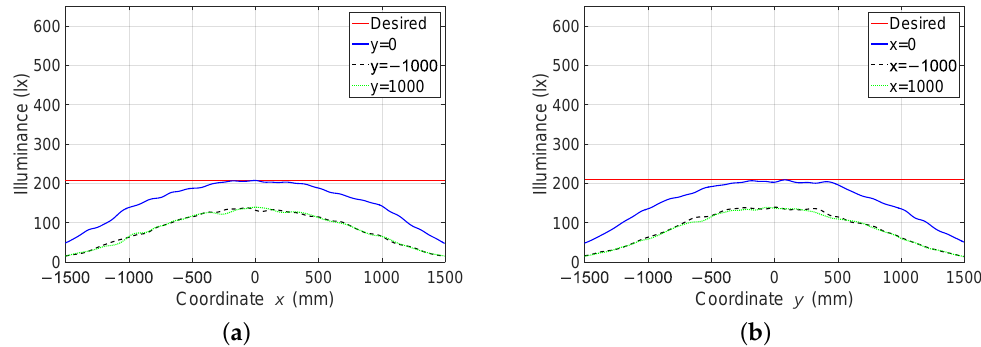
Figure 16. Illuminance distribution curves of the three profiles found using the BBO optimization algorithm: ( a ) on the coordinate axis x and ( b ) on the coordinate axis y .